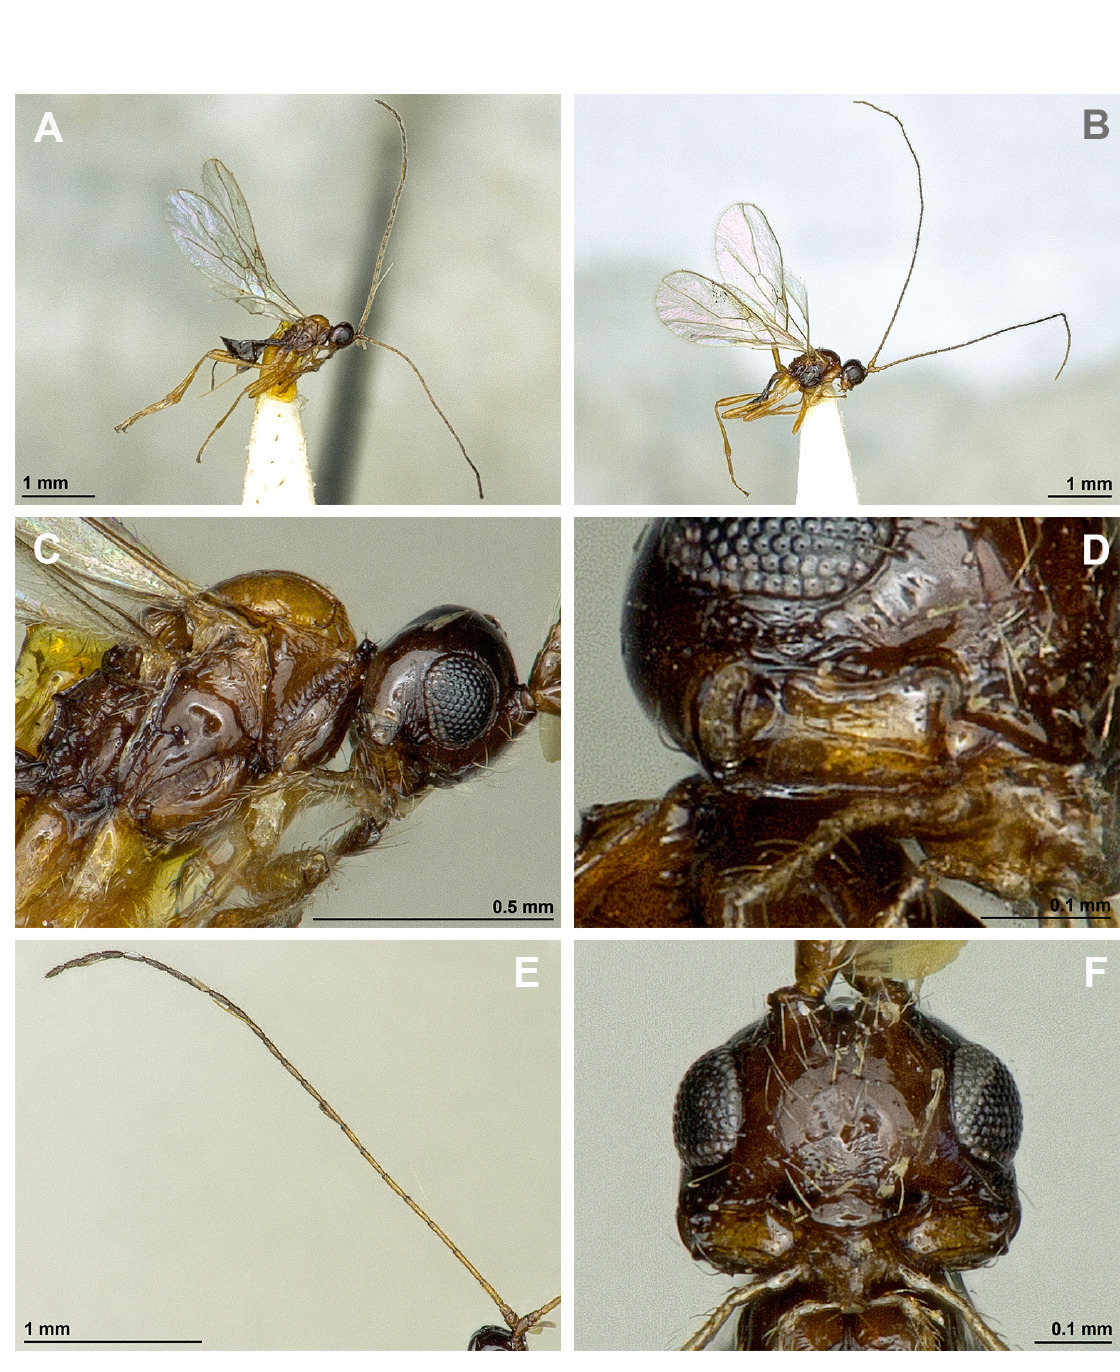
Fig. 17. Asobara fletcheri Peris-Felipo, sp. nov., A, C–F: ♀, holotype (BMNH 1952-566); B: ♂ (BMNH). A–B . Habitus, lateral view. C . Head and mesosoma, lateral view. D . Mandible. E . Antenna. F . Head, front